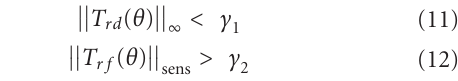
K is a known controller. d ∈ R q d represents exogenous dis- turbances and f ∈ R q f represents the faults to be detected.